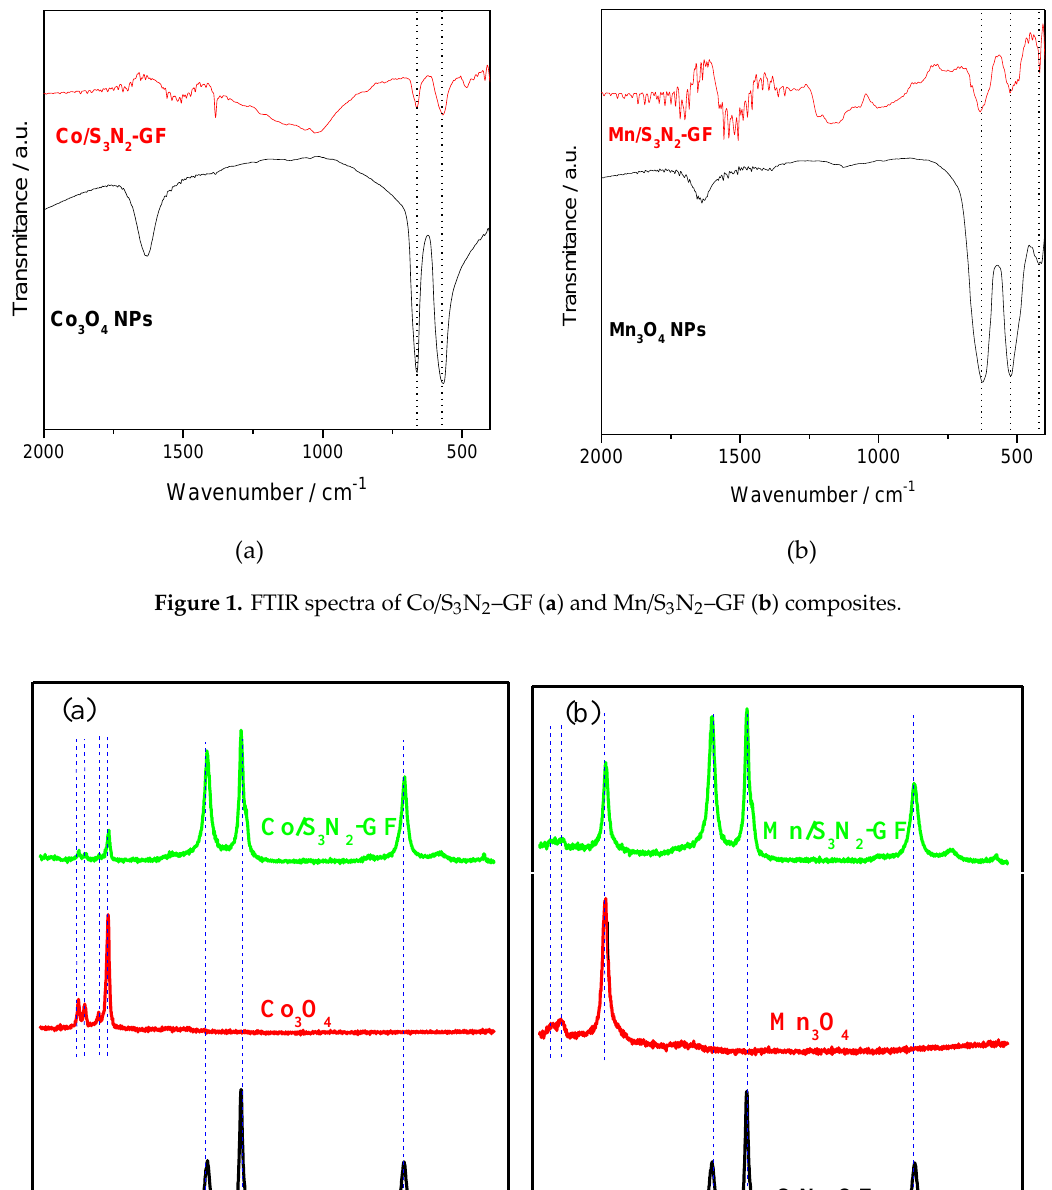
Figure 2. Raman spectra of Co/S 3 N 2 –GF ( a ) and Mn/S 3 N 2 –GF ( b ) composites.